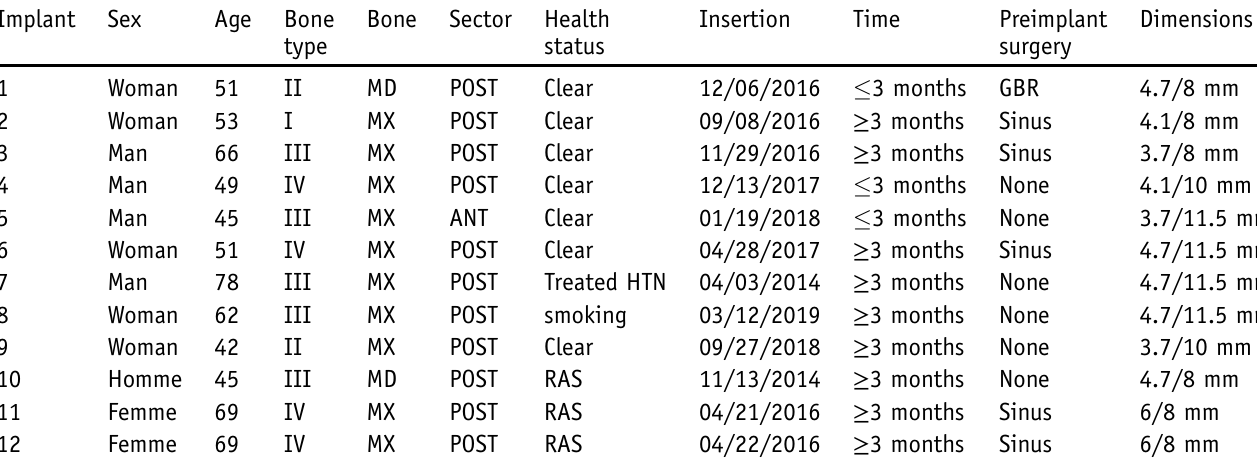
Table I. Clinical data and characteristics of implant failures (RA: Rheumatoid Arthritis; HTN: Hypertension). Implant Sex Age Bone